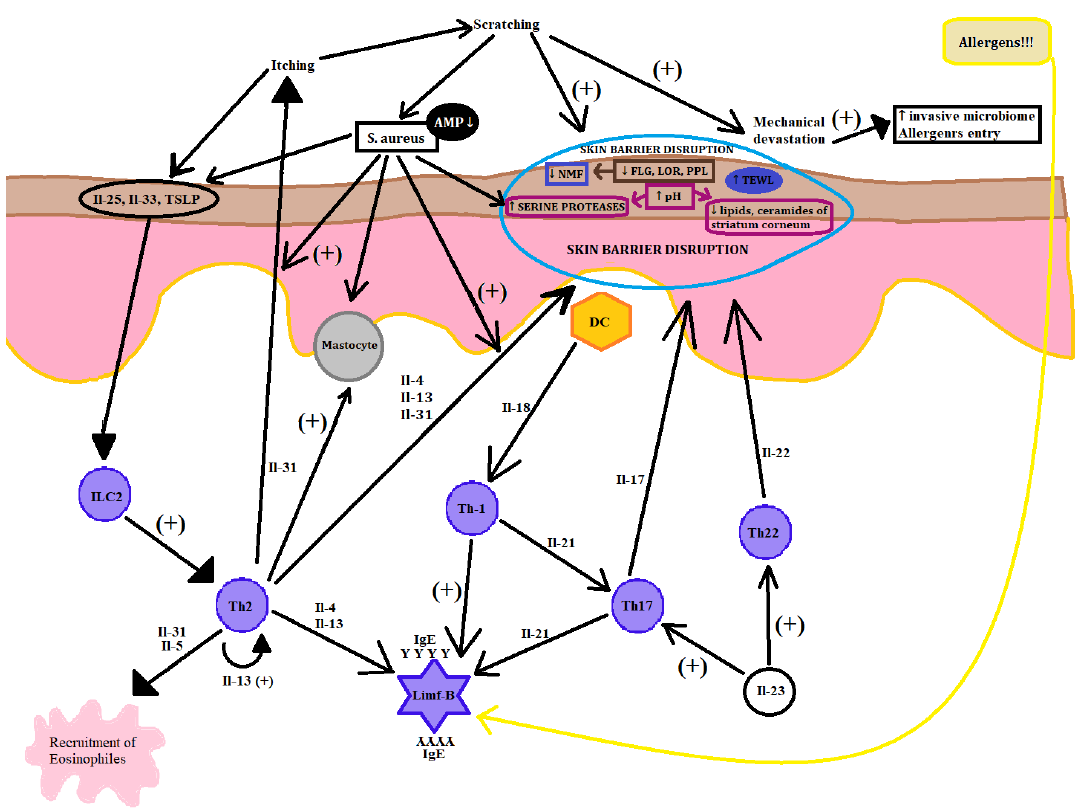
Figure 3. AD pathogenesis. A compound process in the picture unveiled the combined pathogenesis of AD that leads to the acute phase of the disease. The picture is simplified to understand the influence of many different factors including environment on AD focus. Key (+: stimulation, ↑ : increase, ↓ : decrease).